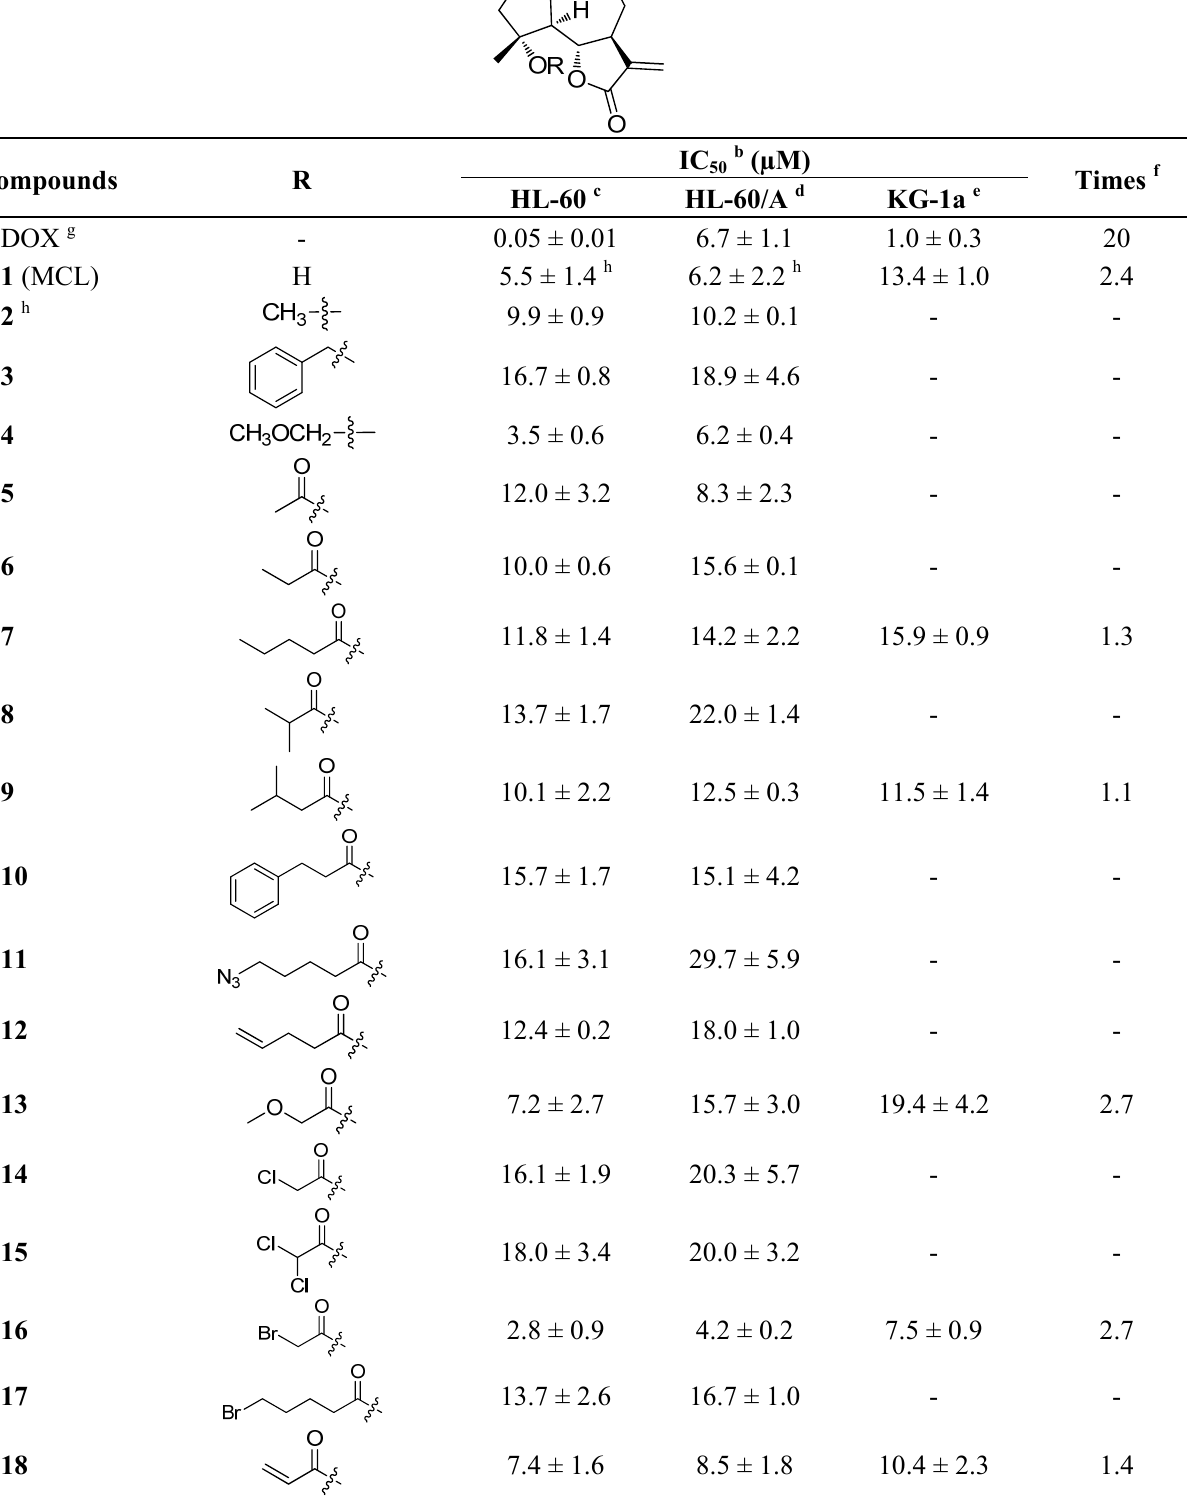
Table 1. Inhibitory effects of compounds 1 – 23 on HL-60, HL-60/A, and KG-1a cell lines a .